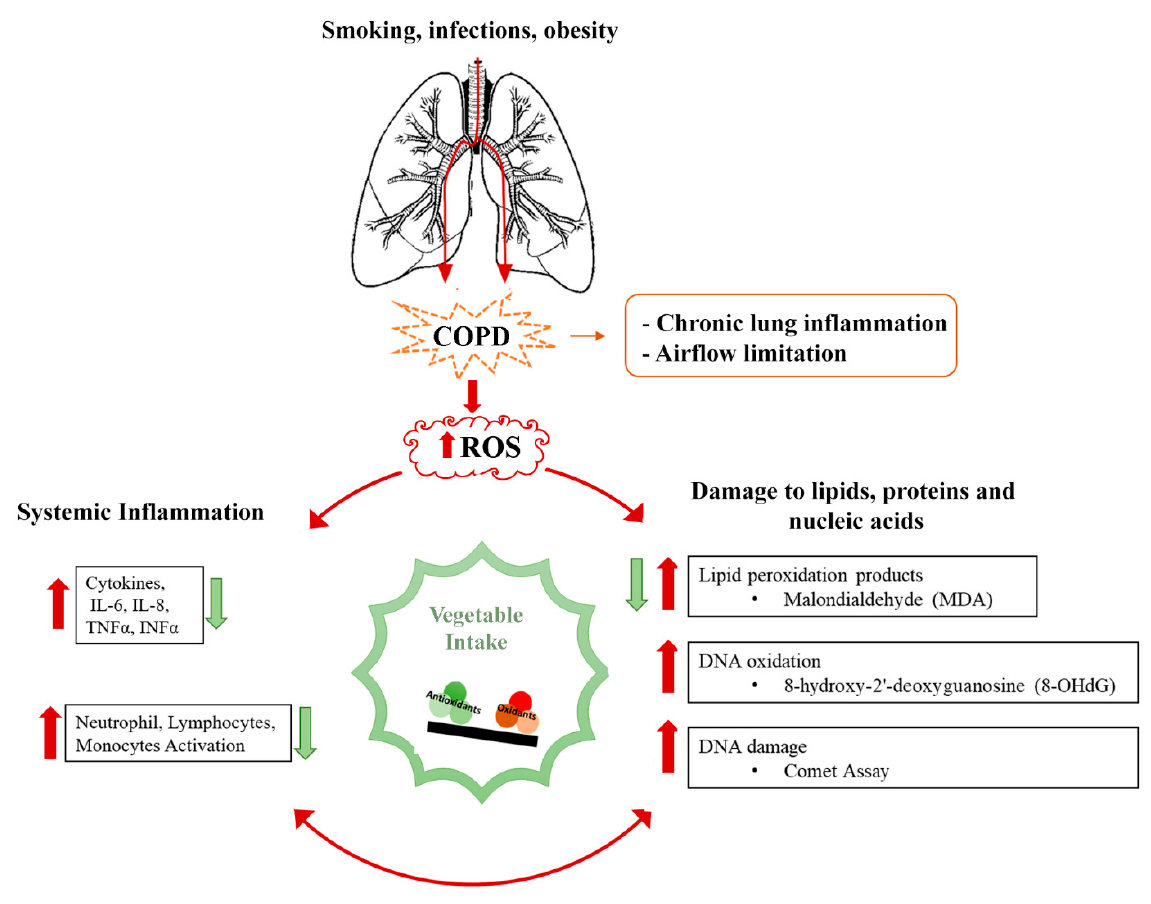
Figure 2. Scheme summarizing this study. Continued production of ROS (red arrow), due to increased oxidative stress, systemic inflammation, and DNA damage (red arrows), is responsible for the development and maintenance of severe COPD. This mechanism is attenuated following the pulmonary rehabilitation program and through a high vegetable intake (green